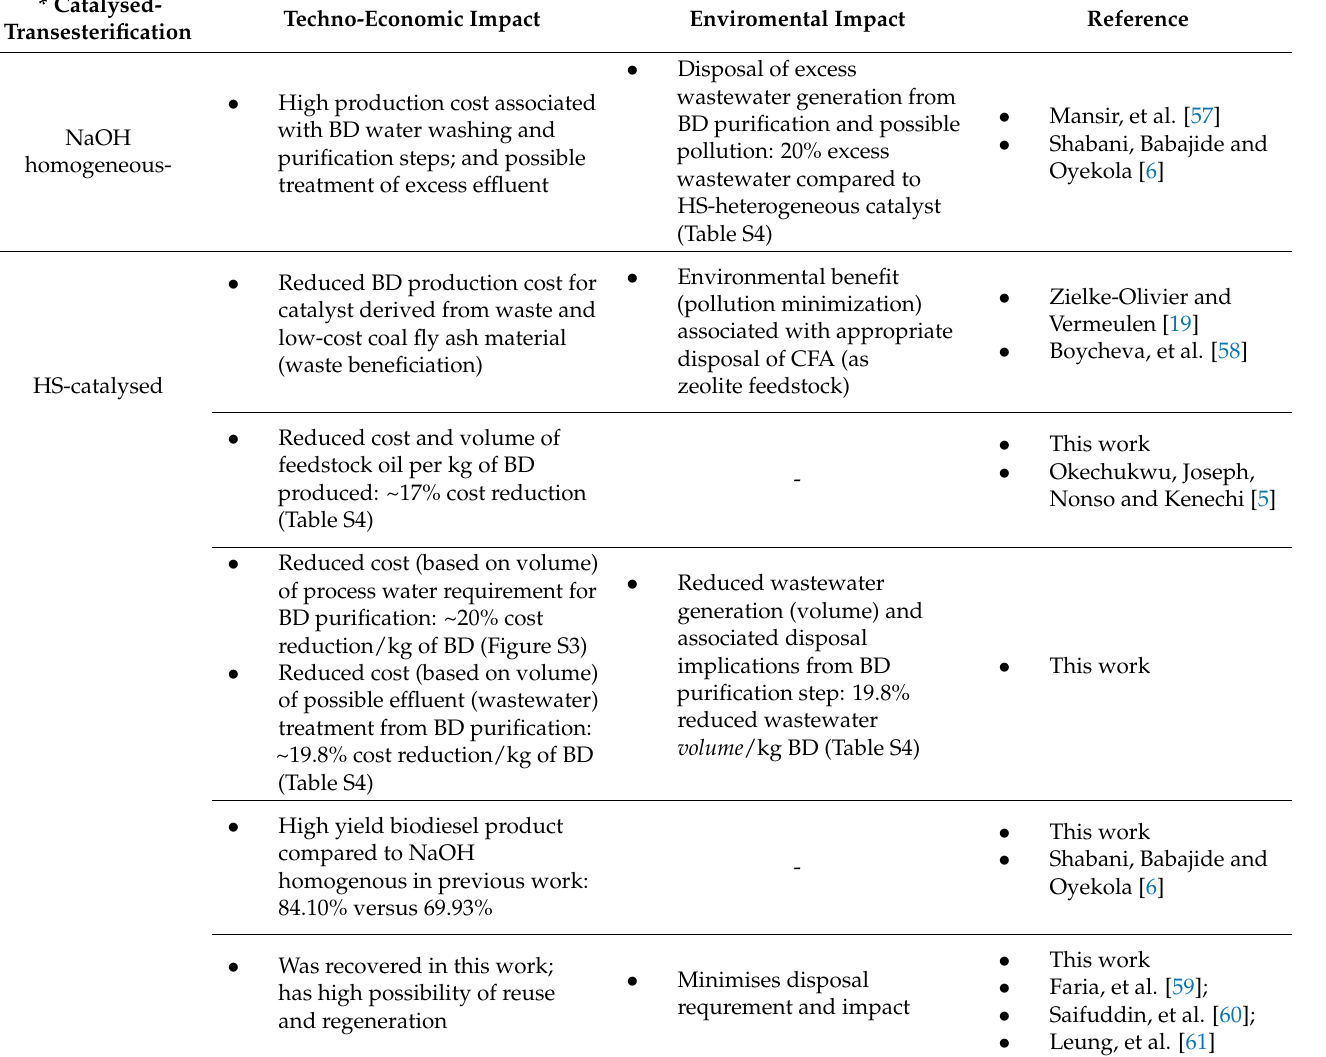
Table 5. Economic and environmental benefit/impact of HS heterogeneous catalyst compared to NaOH homogeneous-transesterification in biodiesel